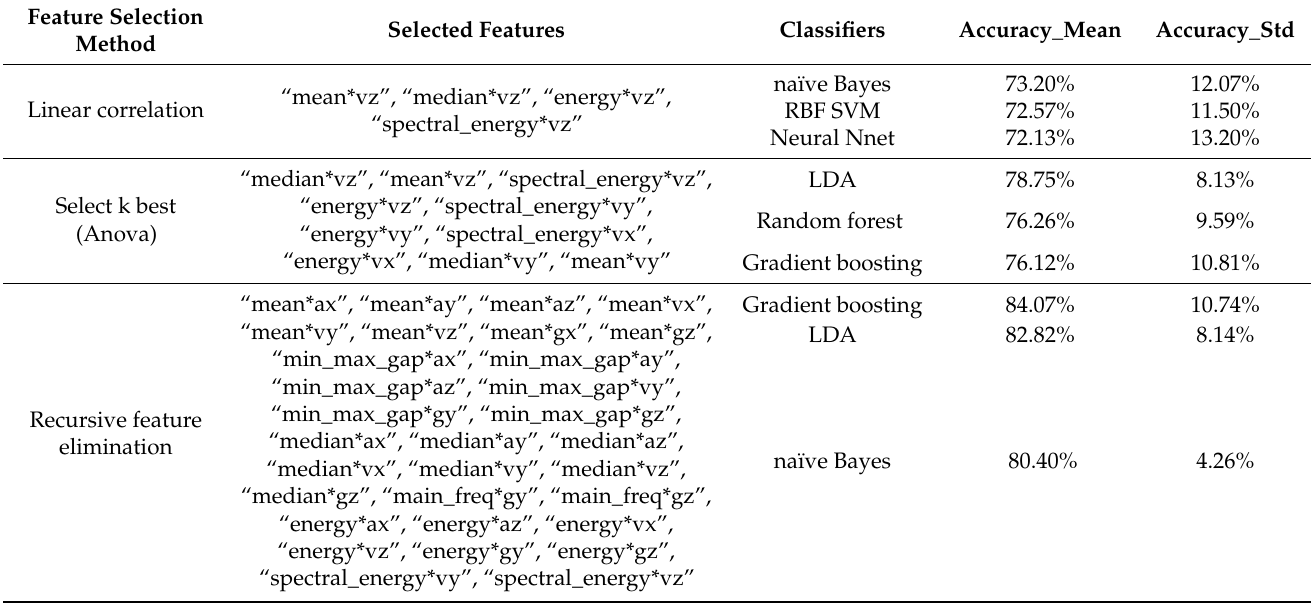
Table 7. Cross-validation for algorithm-based feature